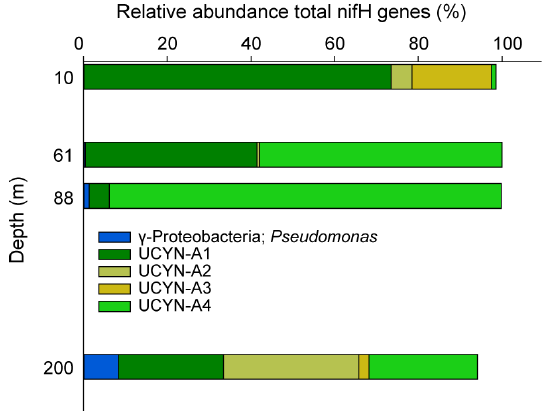
Figure 4. Vertical distribution of the 20 most abundant nifH ASVs at Station 10, collapsed into major taxonomic